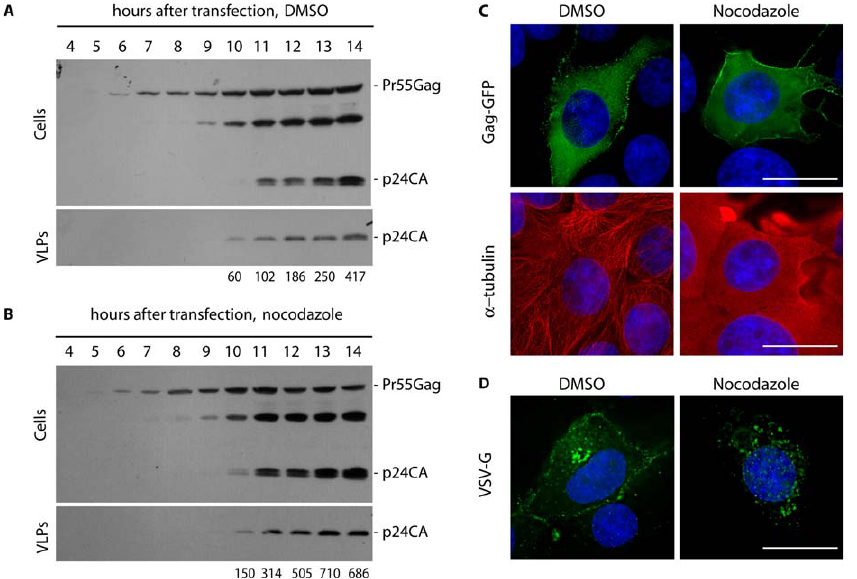
Figure 1. Efficient HIV-1 Particle Formation in the Absence of Microtubules (A and B) Western blot analysis of 293T cells expressing HIV-1 Gag-Pol in the absence (A) or presence (B) of nocodazole, added immediately after transfection. Samples were collected every hour, as indicated, and cell and virion lysates were probed with anti–HIV-1 CA antibodies. Numerical values below the blots indicate VLP p24CA signal intensities, derived by densitometry; absence of a value indicates undetectable signal. (C) 293T cells expressing Gag-GFP (green) in the absence or presence of nocodazole were fixed 14-h post-transfection. Samples were stained with anti– a -tubulin antibodies (red) and with Hoechst 33258 (blue). Scale bars indicate 8 l m. (D) 293T cells expressing VSV-G in the absence or presence of nocodazole were fixed 14-h post-transfection. Samples were stained with anti–VSV-G antibodies (green) and with Hoechst 33258 (blue). Scale bar indicates 8 l m. DOI: 10.1371/journal.pbio.0040435.g001